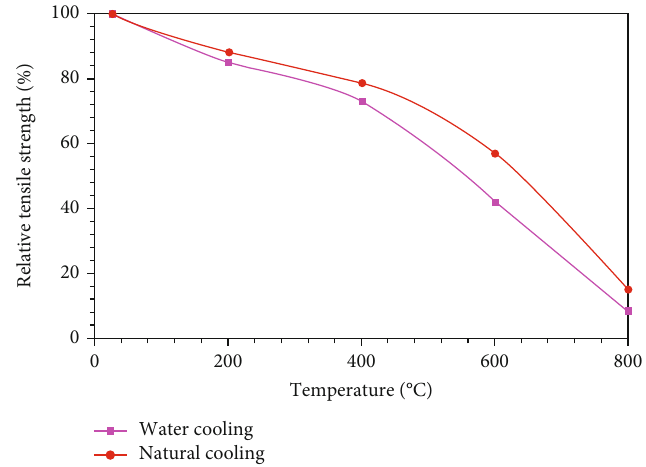
Figure 5: The variations of the tensile strength of core samples with temperature under two di ff erent cooling